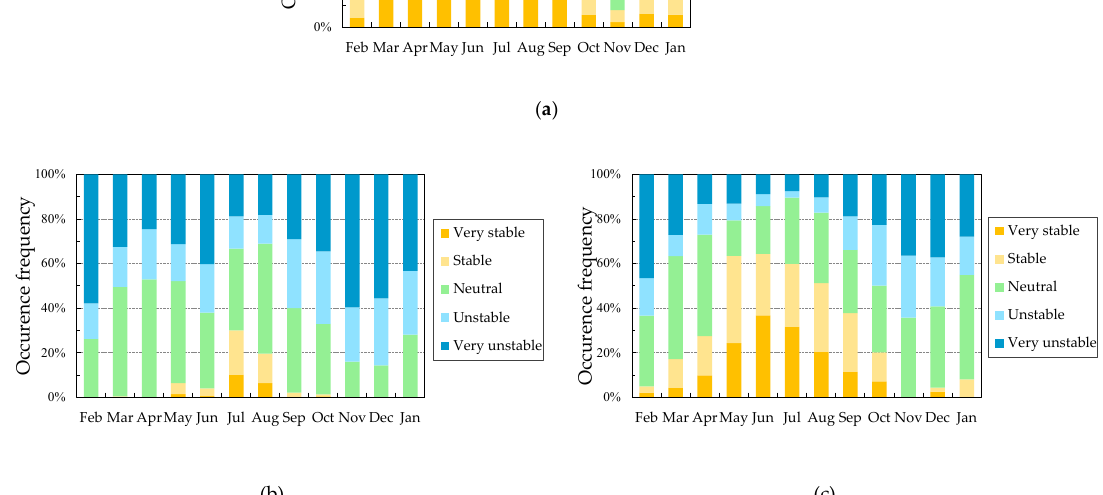
Figure 16. Seasonal variation of atmospheric stability: ( a ) Observation, ( b ) USGS+FNL (Case4.1) and ( c ) NLID+BIAS Corrected SST (Case4.2).